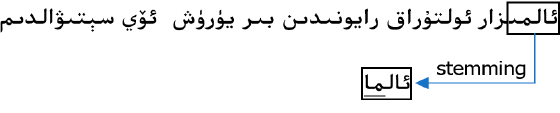
Figure 7. Stem-based string scanning.